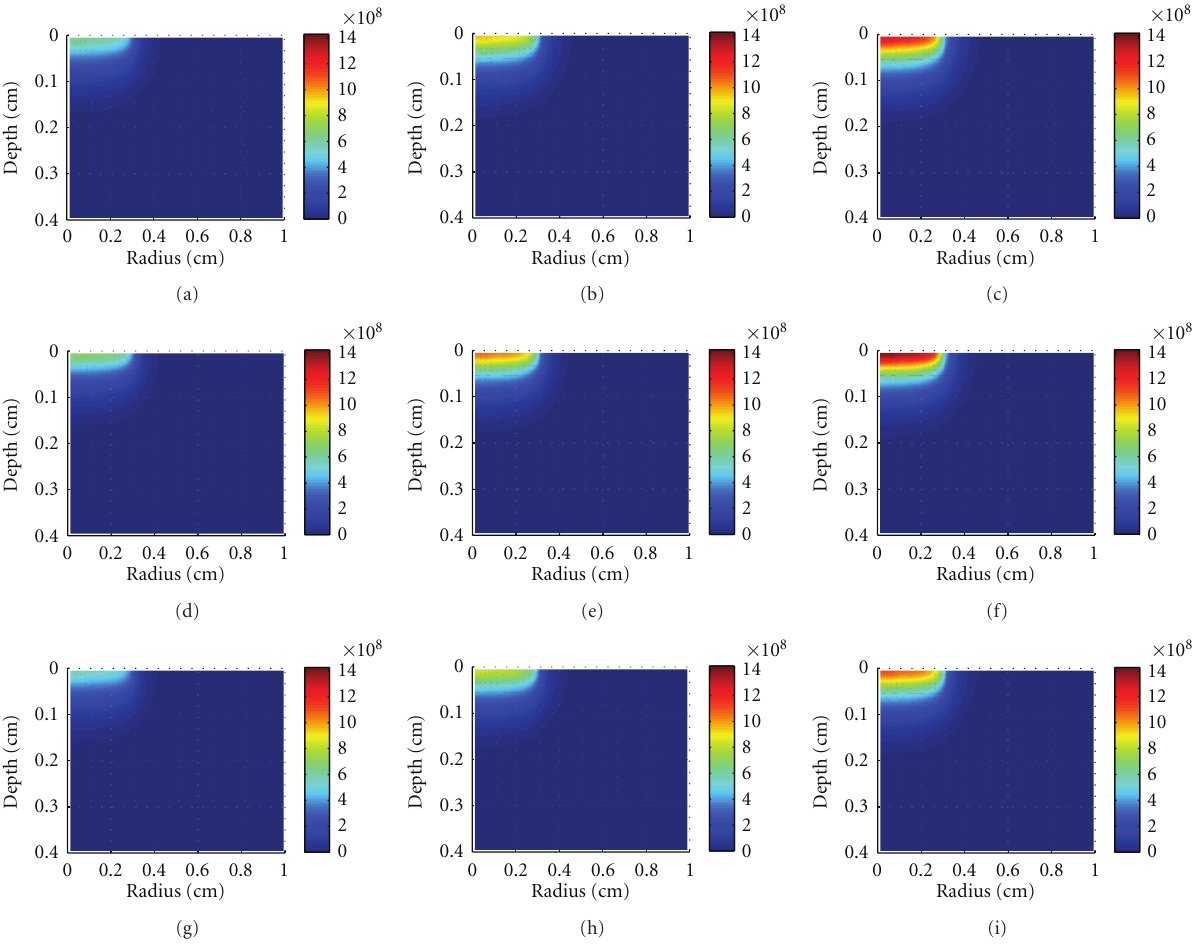
Figure 3: Maximum singlet oxygen concentration (cm − 3 ) in nodular BCC tumor: (a) 100mW/cm 2 , (b) 150 mW/cm 2 , (c) 200 mW/cm 2 ; in infiltrative BCC tumor: (d) 100 mW/cm 2 , (e) 150mW/cm 2 , (f) 200 mW/cm 2 ; in SCC: (g) 100 mW/cm 2 , (h) 150 mW/cm 2 , (i) 200 mW/cm 2